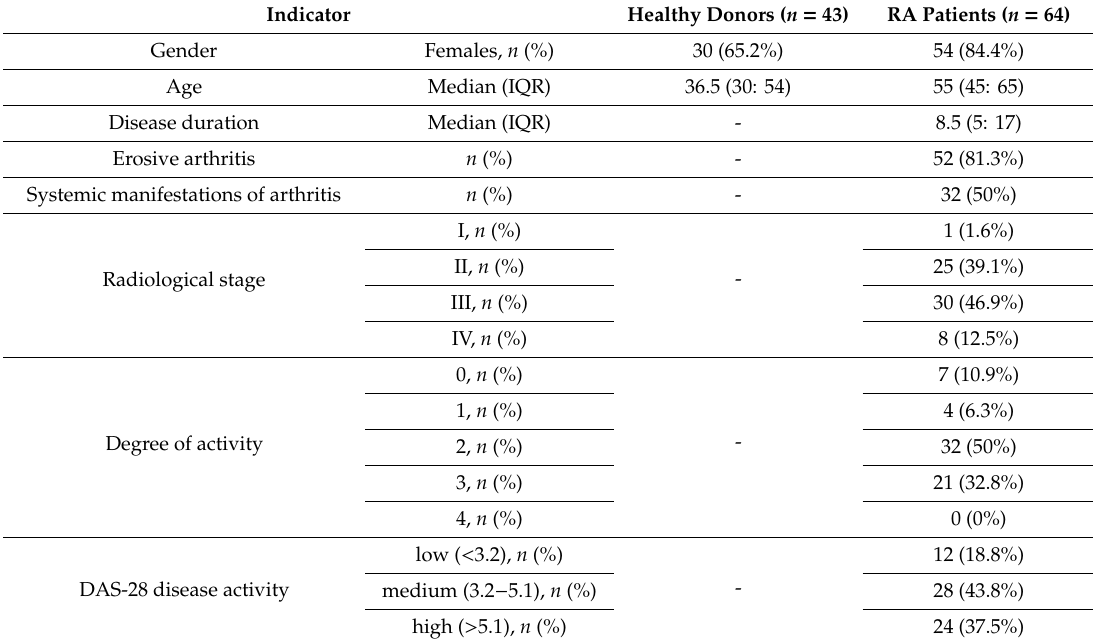
Table 4. Baseline characteristics of the studied